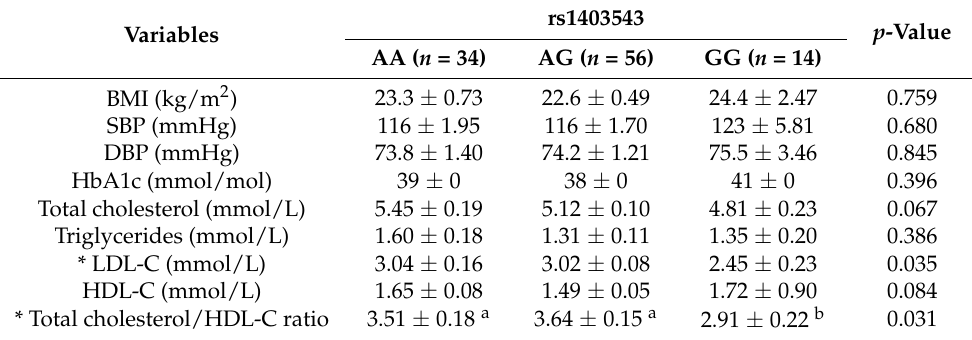
Table 4. Values of CVD metabolic risk factors according to the genotype of the AGTR2 gene rs1403543 SNP for Chinese female subjects ( n =